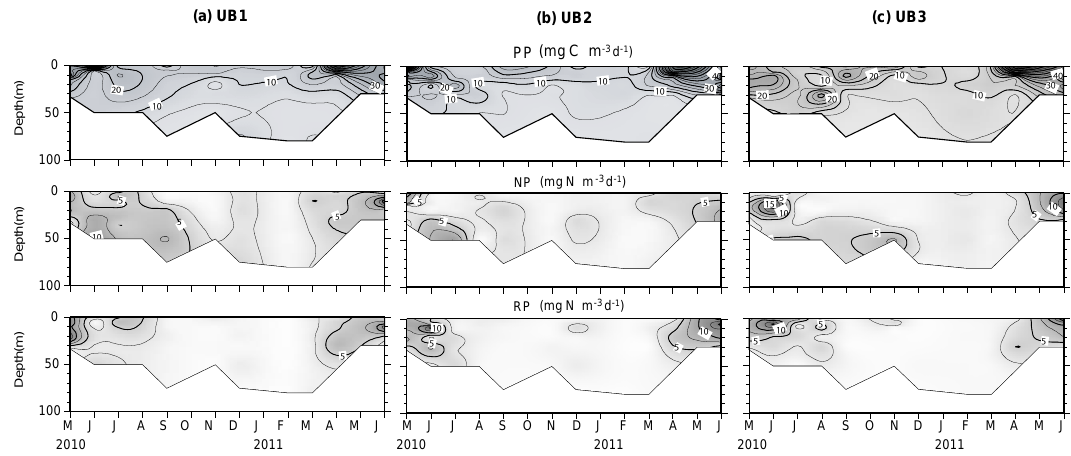
Fig. 7. Contour plots of primary productivity (PP), new productivity (NP), and regenerated productivity (RP) observed at the three stations during our study period.